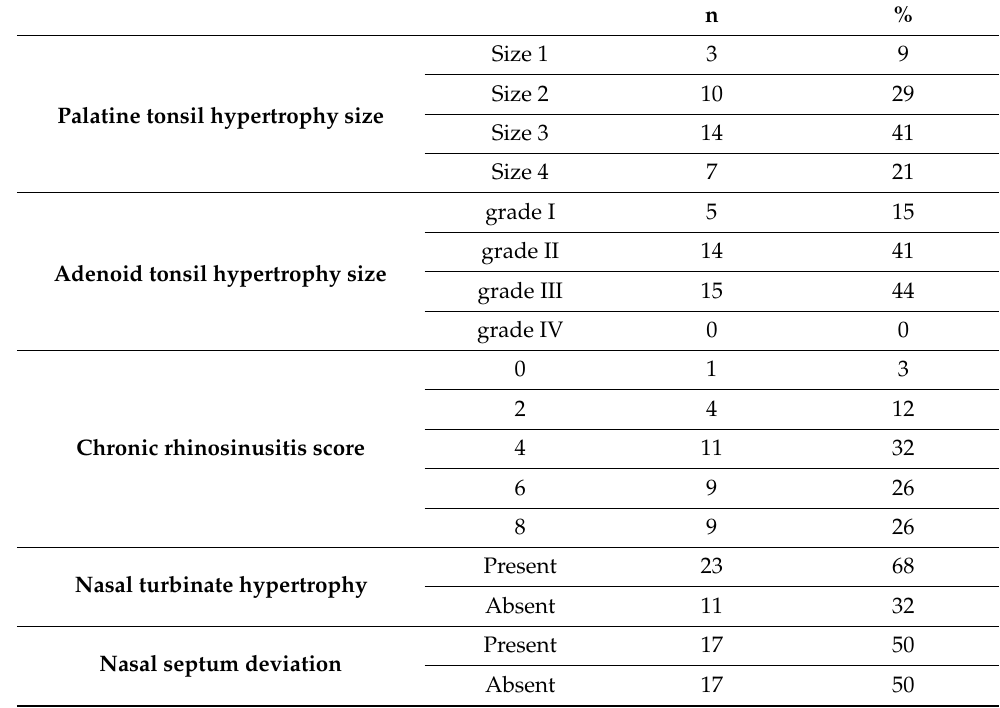
Table 2. Summary of the results of the ear, nose, throat assessment in Down syndrome children.